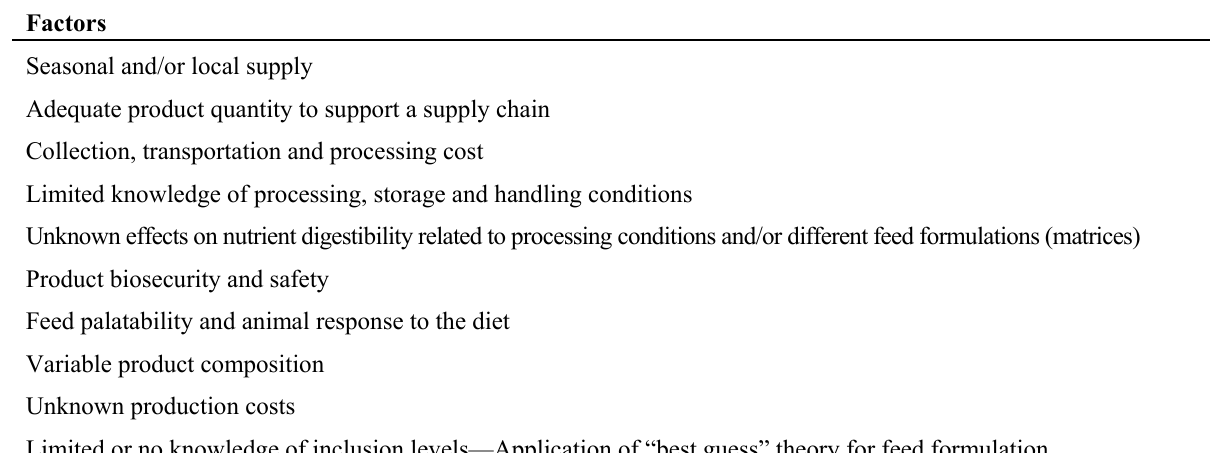
Table 4. Factors and requirements for the application of fruit and vegetable co-products in farm animal